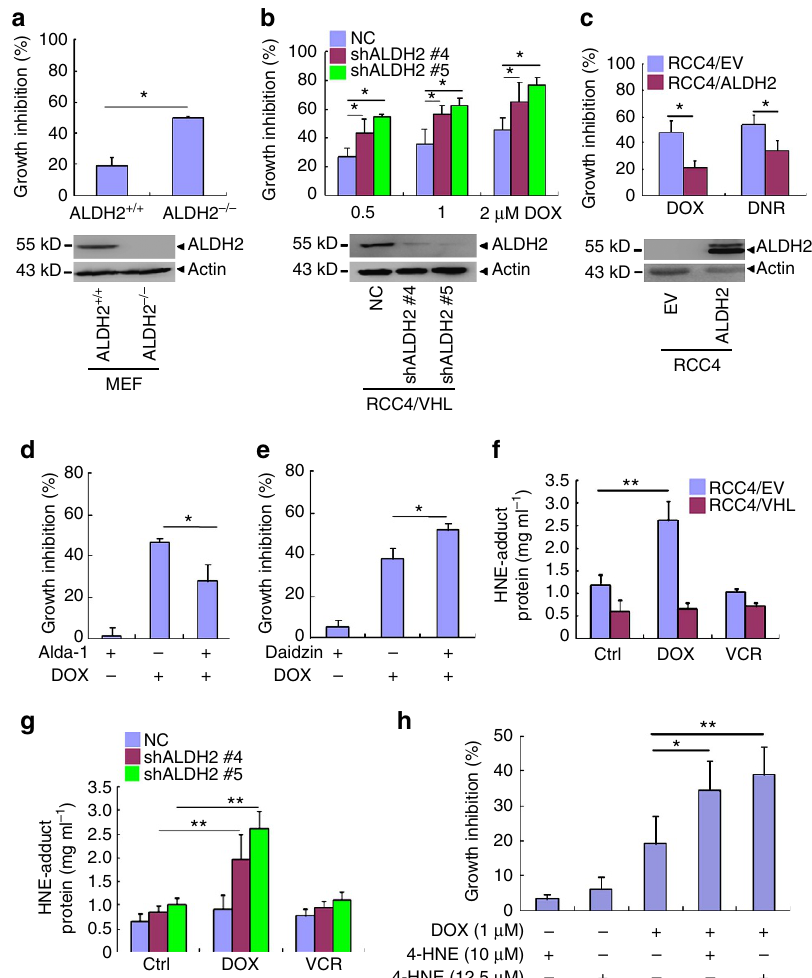
Figure 5 | ALDH2 mediates the enhanced cytotoxicity of anthracyclines in VHL-deficient ccRCC cells. ( a – c ) The cell growth inhibition rates of the indicated cells (top) and the indicated proteins were detected by western blot (bottom). ( a ) The primary embryo fibroblast (MEF) cells from ALDH2 knockout mice. ALDH2 þ / þ and ALDH2 (cid:2) / (cid:2) represent MEF cells from ALDH2 wild type and knockout mice, then treated by 1 m M doxorubicin for 24h. ( b ) RCC4/VHL cells were stably transfected with shRNAs against ALDH2 (#4 and #5), then treated with 1 m M doxorubicin for 48h. ( c ) RCC4 cells were stably transfected with ALDH2 expression vector and treated by 1 m M doxorubicin or daunomycin for 24h. ( d , e ) The growth inhibition rates of RCC4/VHL cells treated by indicated drugs. ( d ) RCC4/VHL cells were pretreated with 50 m M ALDH2 activator alda-1 for 1h, then treated in combination with 1 m M DOX for 48h. ( e ) Pretreatment with 60 m M ALDH2 inhibitor daidzin for 24h, then treated RCC4/VHL cells in combination with 1 m M DOX for 48h. ( f , g ) HNE-adduct protein levels of the indicated cells treated by 1 m M DOX or VCR for 24h. ( h ) The growth inhibition rates of RCC4/VHL cells treated by DOX and/or 4-HNE for 24h. Columns, means of three independent experiments; bars, s.d. (* P o 0.05,** P o 0.01 for t